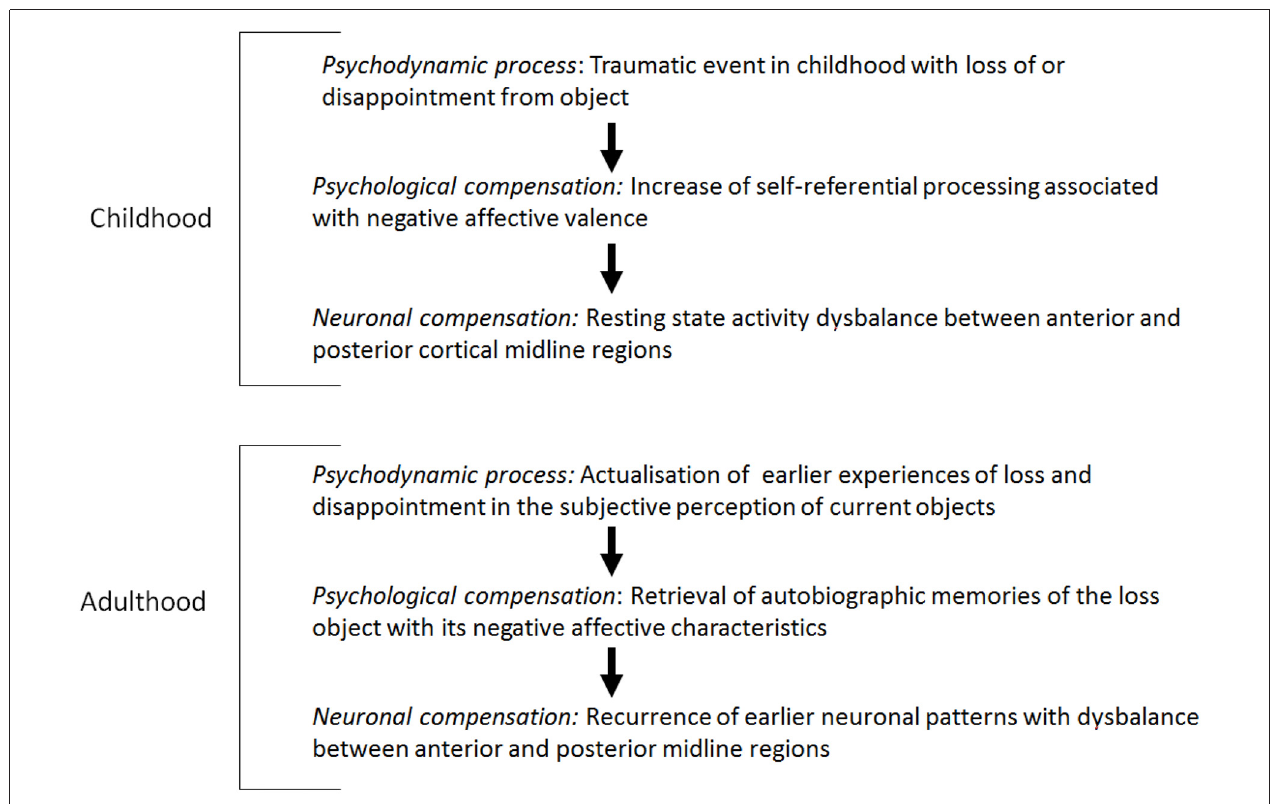
FIGURE 1 | Resting state activity: dysbalance and mental reactivation of lost